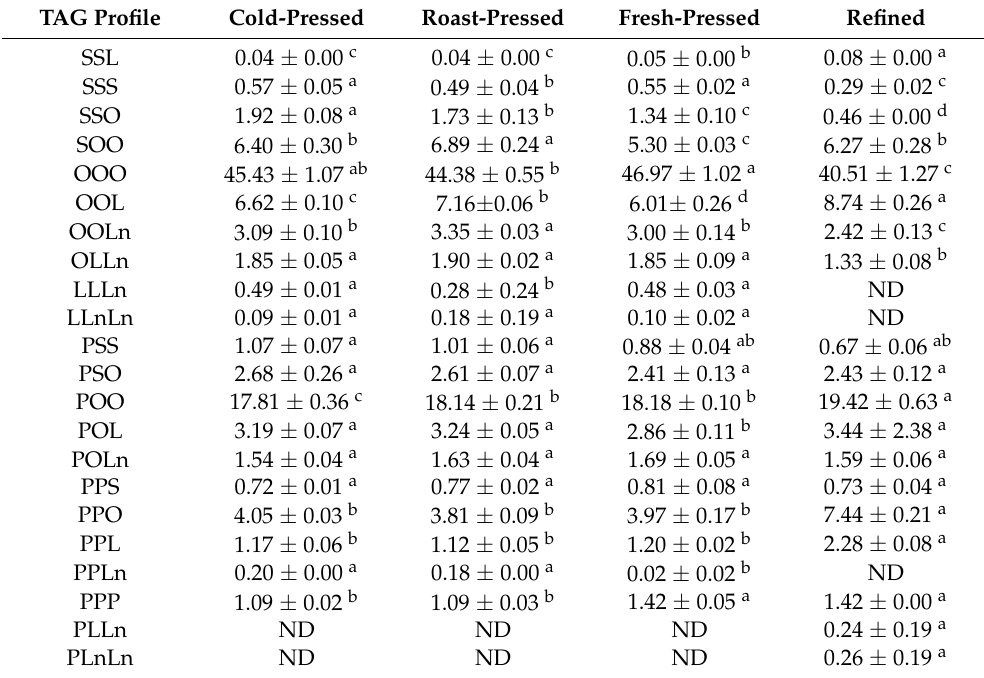
Table 1. TAGs profile of camellia oils (%). TAG